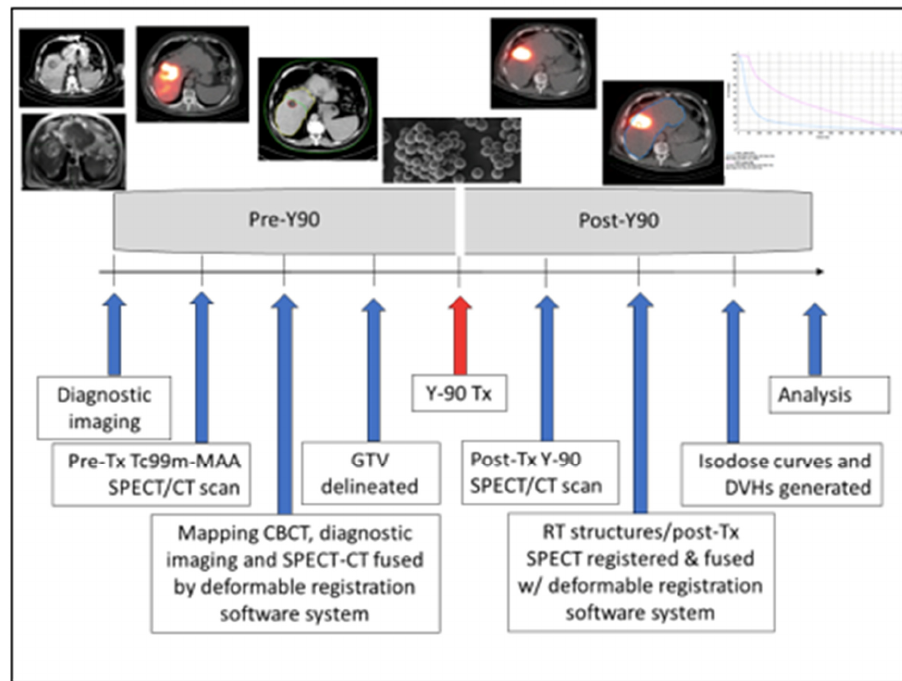
Figure 1. TARE Y-90 dosimetry workflow.